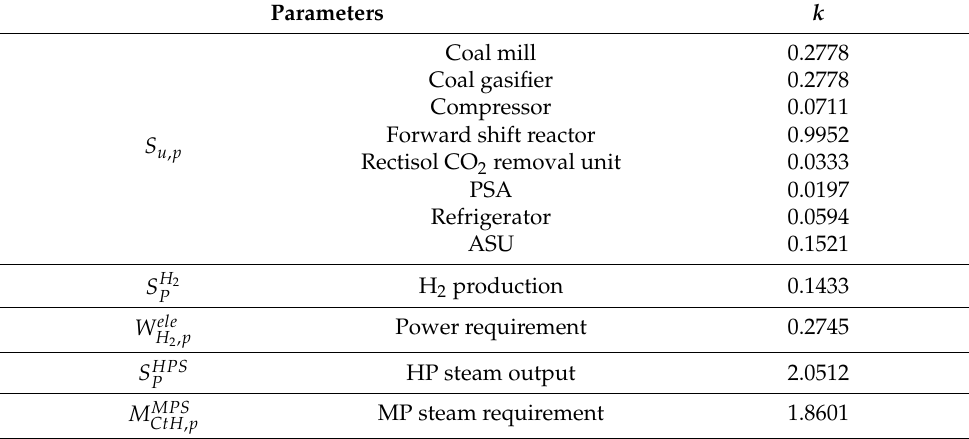
Table 3. Regression coefficients of the parameters in the CtH